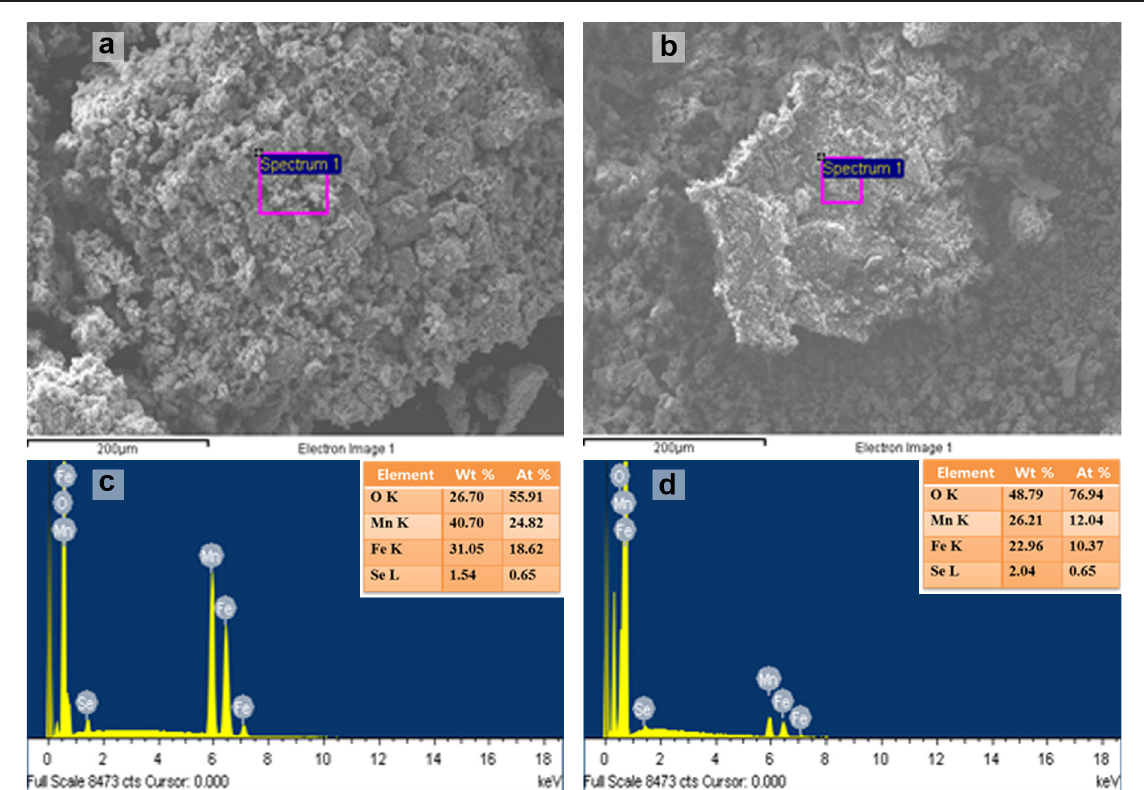
Fig. 2. SEM image and SEM-EDX after adsorption of Se(IV) on Fe-Mn LDHs (a) and (c) and those after adsorption of Se(IV) onto Fe-Mn Dos (b) and (d). FTIR spectra analysis: The original peaks of Fe-Mn LDHs and Fe-Mn DOs are shown in Figure 3.